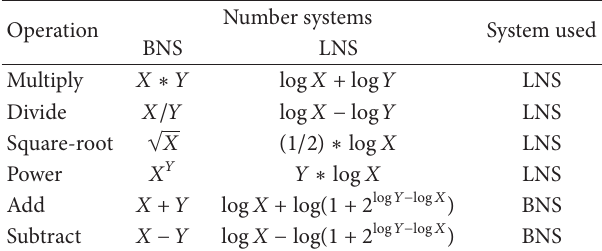
Table 2: Selection of number system based on